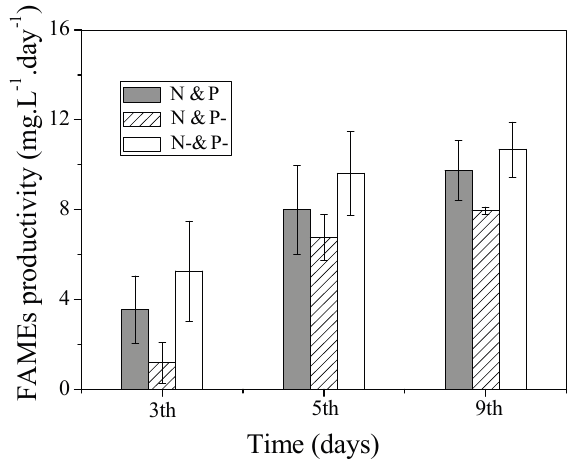
Figure 6. FAME productivity of C. vulgaris cultured in N and P, N and P − , and N − and P − media. Values shown are averages of two samples ±